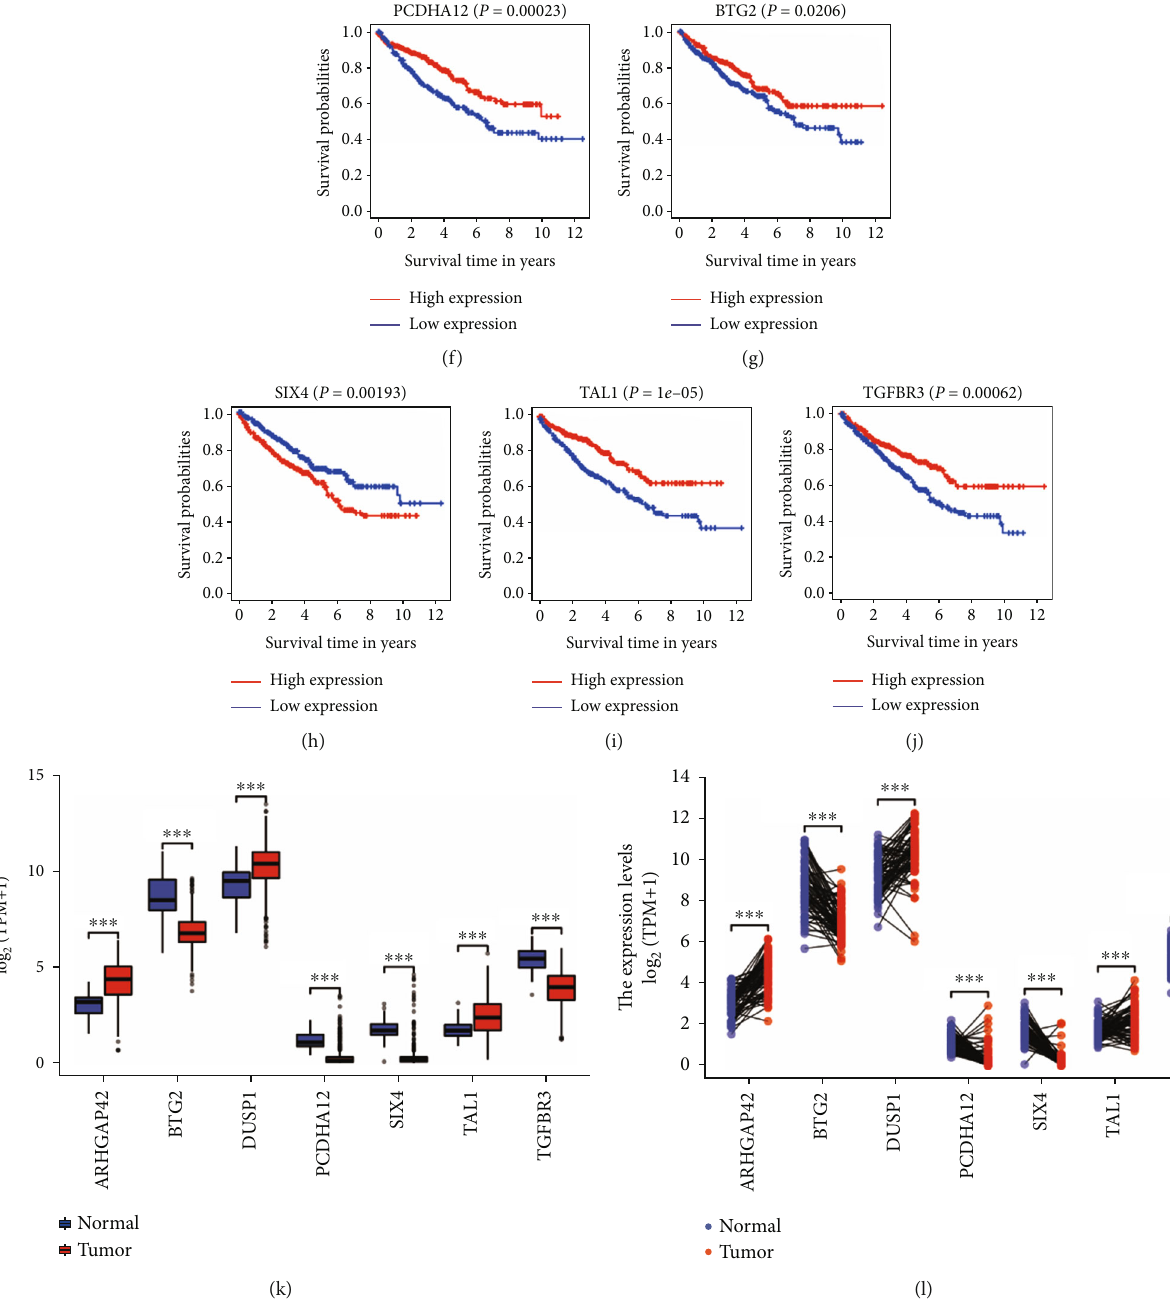
Figure 8: Gene alterations and survival analysis of hub genes. (a) Mutation landscape of 11 hub genes in 336 patients with ccRCC from TCGA dataset. (b) Copy number variation (CNV) frequency of 11 hub genes in TCGA cohort. The height of the columns represents the alteration frequency. (c) Location of CNV alteration of 11 hub genes. (d – j) Kaplan-Meier survival curves show seven hub genes associated with patient prognosis. Red: high expression; blue: low expression. (k) Expression di ff erences of seven hub genes in tumor tissues and unpaired normal tissues. (l) Expression di ff erences of seven hub genes in tumor tissues and paired normal tissues. Red: tumor; blue: normal; ns: P ≥ 0 : 05 ; ∗ P < 0 : 05 ; ∗∗ P < 0 : 01 ; ∗∗∗ P < 0 : 001 downregulated miRNAs (hsa-miR-500a-3p, hsa-miR-200a- 5p, hsa-miR-381-3p, hsa-miR-214-3p, and hsa-miR-141- 3p) in tumor samples compared with normal samples